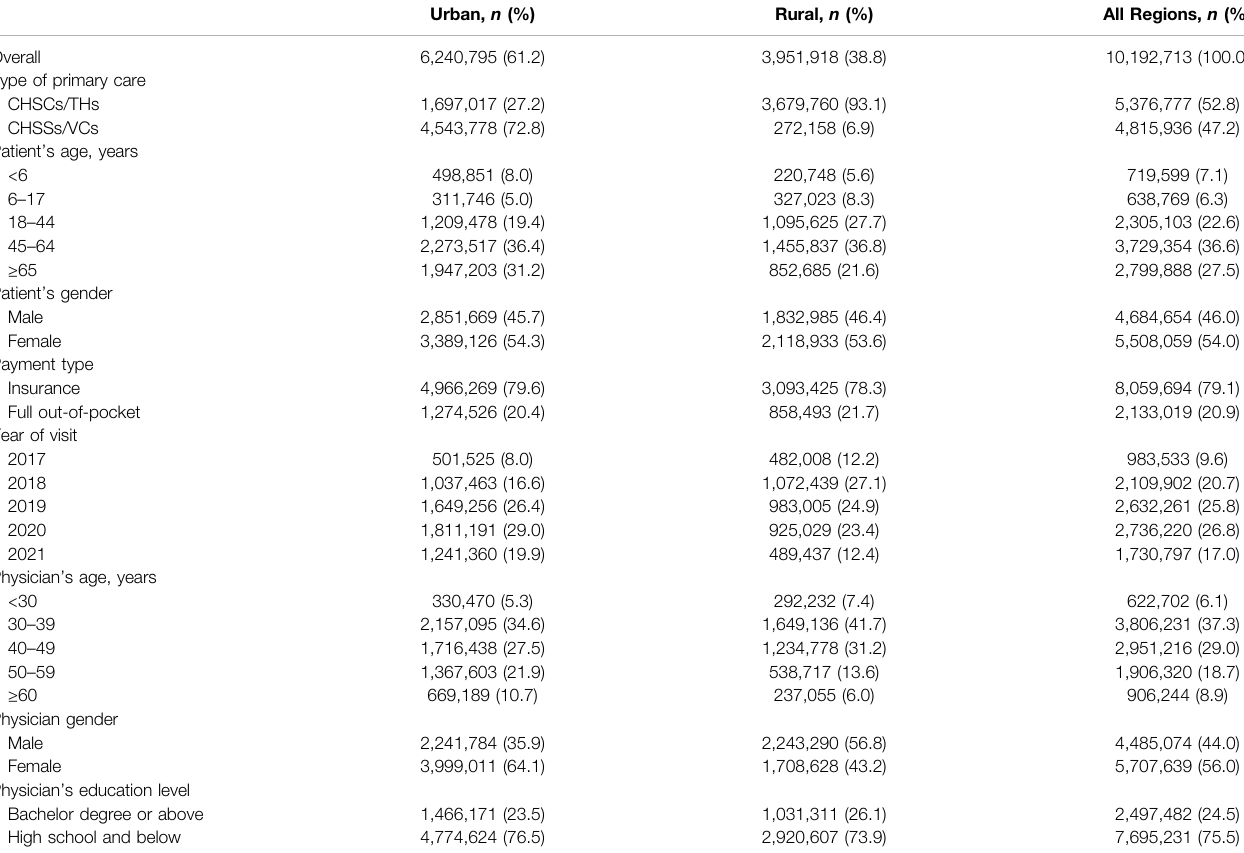
TABLE 1 | Basic characteristics of outpatient visits in primary care setting in Yinchuan City. Urban, n (%) Rural, n (%) All Regions, n